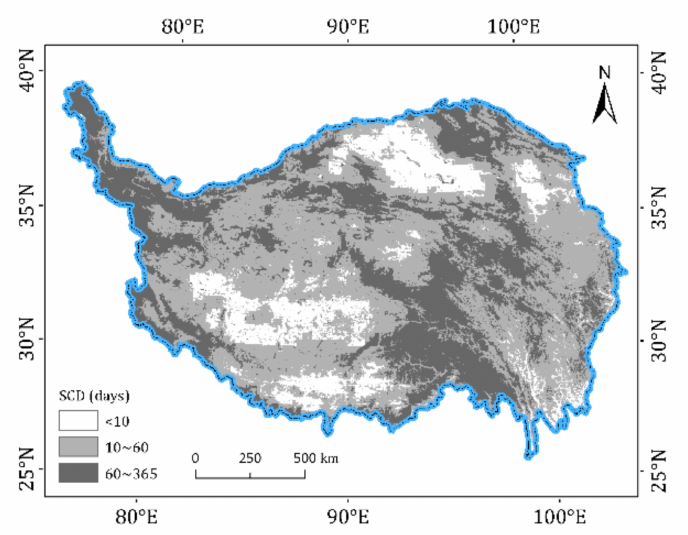
Figure 2. The snow cover duration (SCD) of the Tibetan Plateau [47].